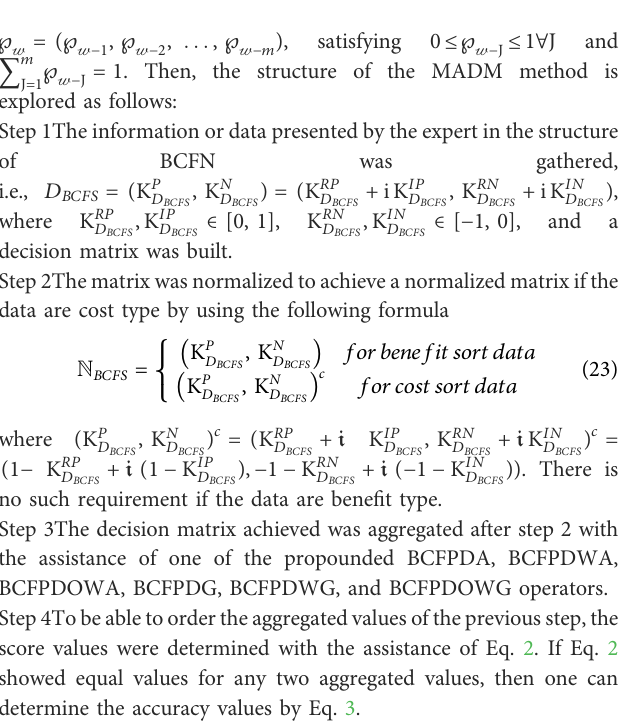
Step 5: Relying on the score values, the ranking is presented in Table